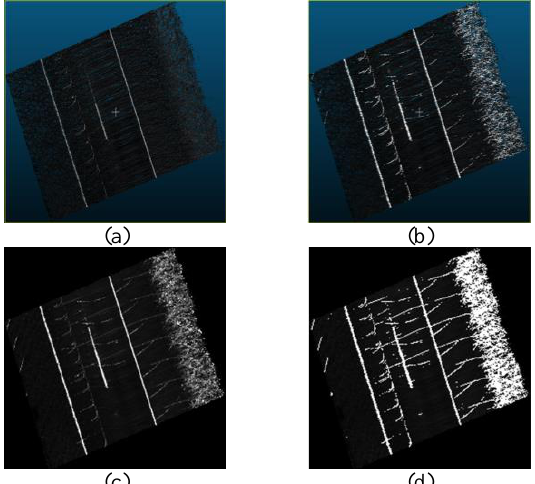
Figure 5. Illustrations of (a) original road surface point cloud block (b) enhanced point cloud block, (c) intensity image, and (d) enhanced intensity image After the intensity image generation, some intensity images are manually labeled to train U-net model 1, while for U-net model thresholding strategy are utilized for generating labels automatically. First, lane markings obtained from the are divided into 12.8-m-long blocks and converted into images